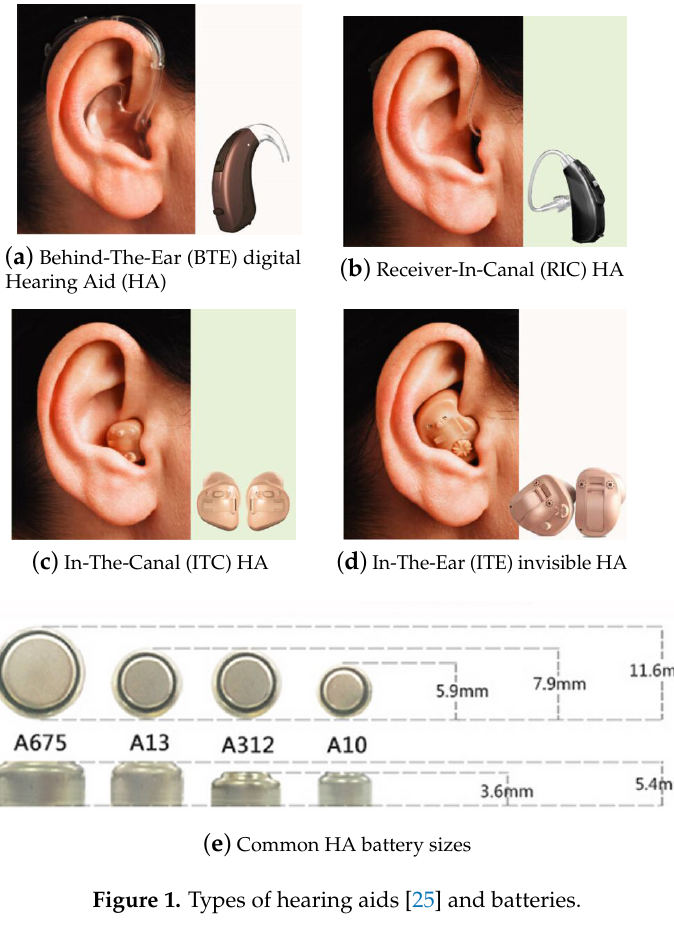
Figure 1. Types of hearing aids [25] and batteries.